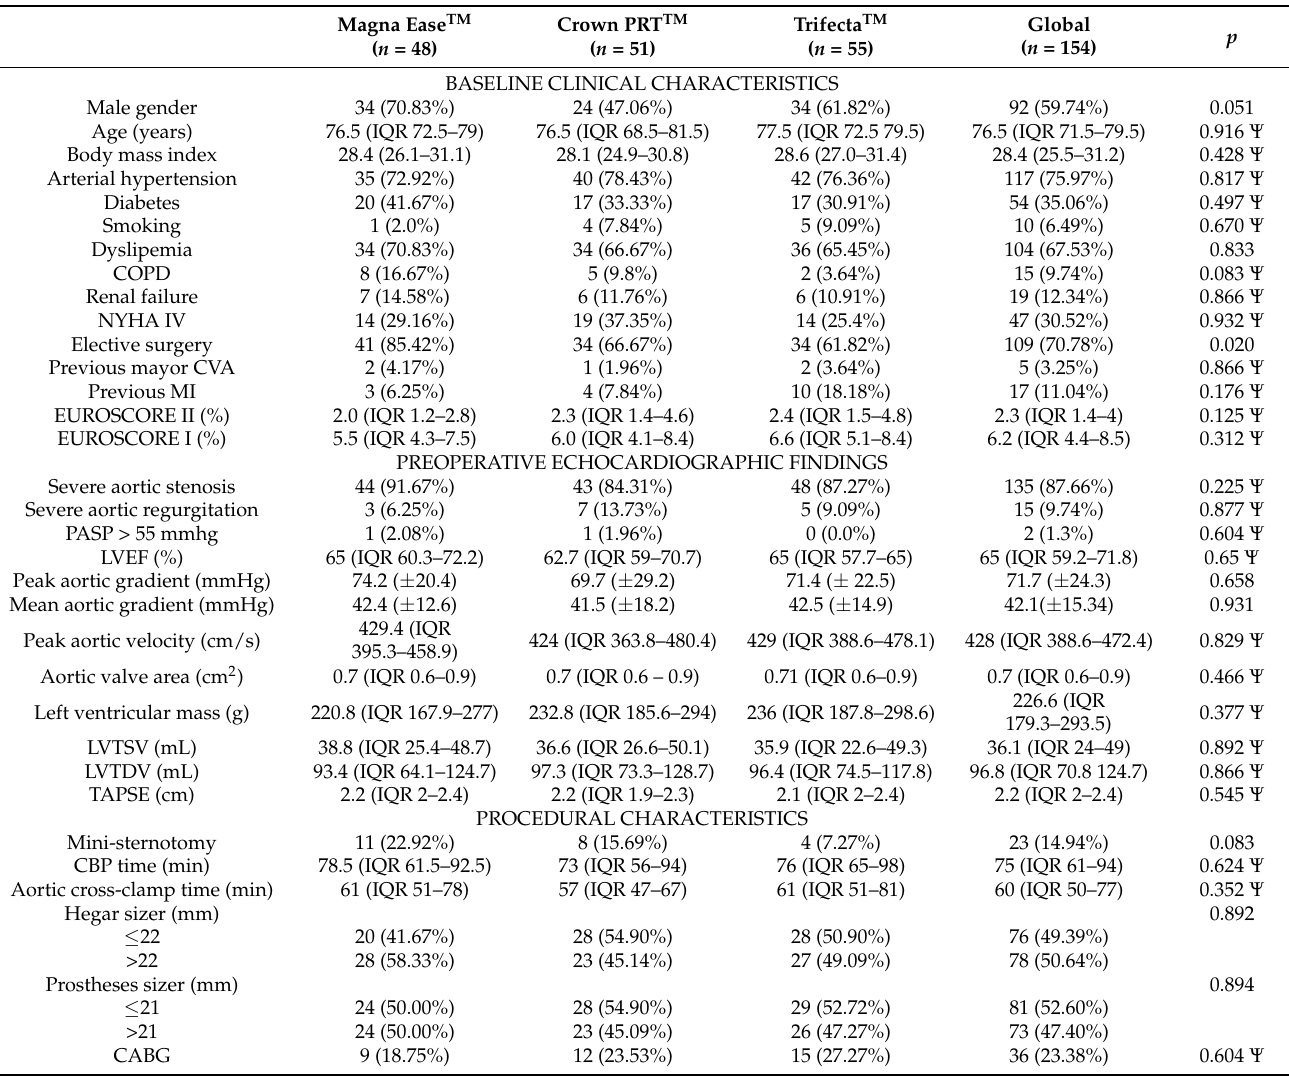
Table 1. Baseline characteristics and echocardiographic